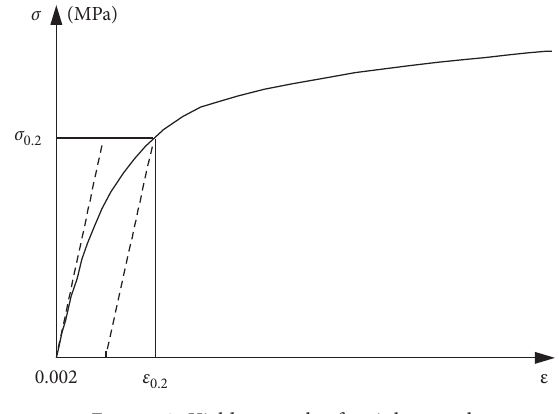
Figure 2: Yield strength of stainless